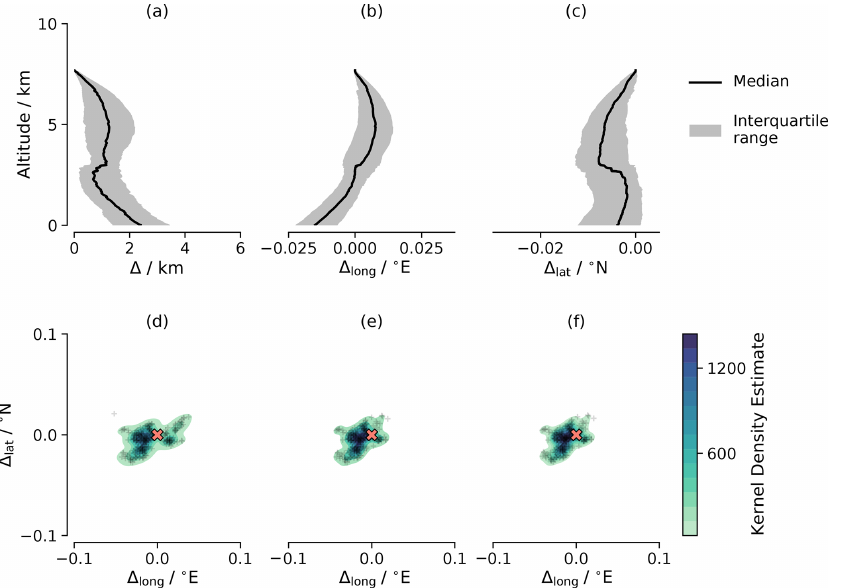
Figure 3. Same as Fig. 2, but for P3 sondes instead of HALO sondes. For (d) , median altitude of maximum drift in the profile, ˜ z =